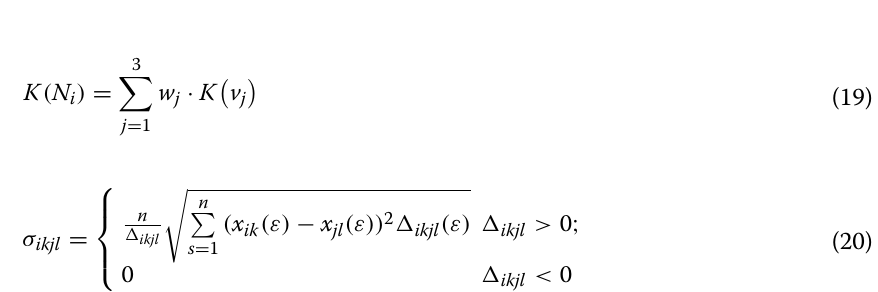
Fig. 1 Maintenance plan